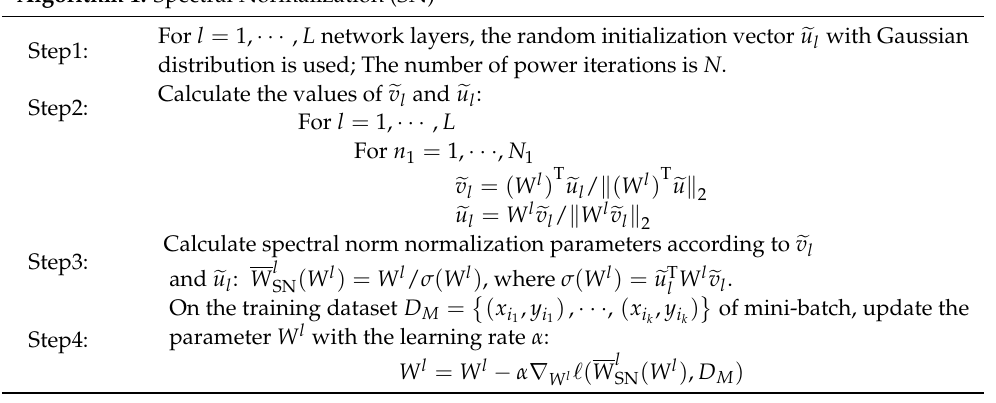
Algorithm 1. Spectral Normalization